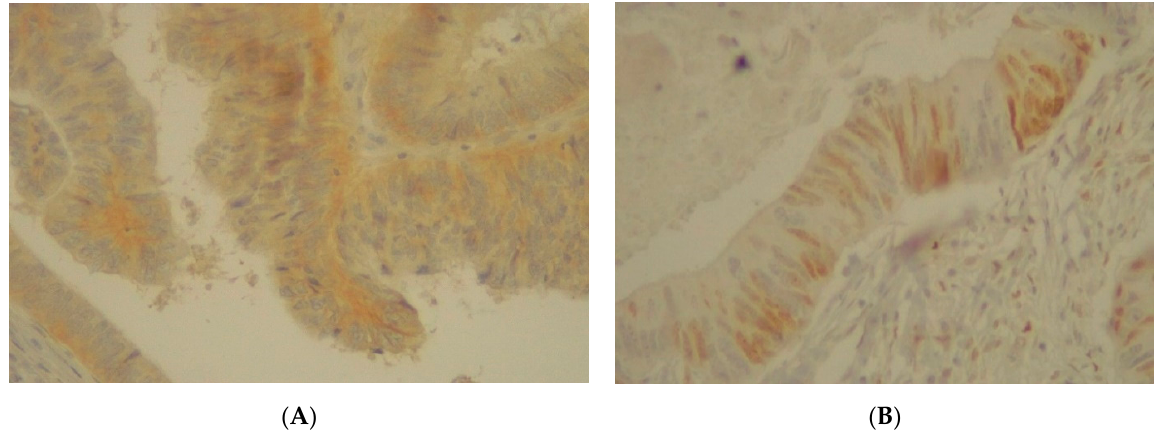
Figure 10. ( A ) Immunohistochemical staining of EGFR in colorectal adenocarcinoma with an intensity score of 2+ with more than 50% of the stained cells. ( B ) Immunohistochemical staining of LEF1 in colorectal adenocarcinoma with a positive expression of more than 20% of the stained cells.